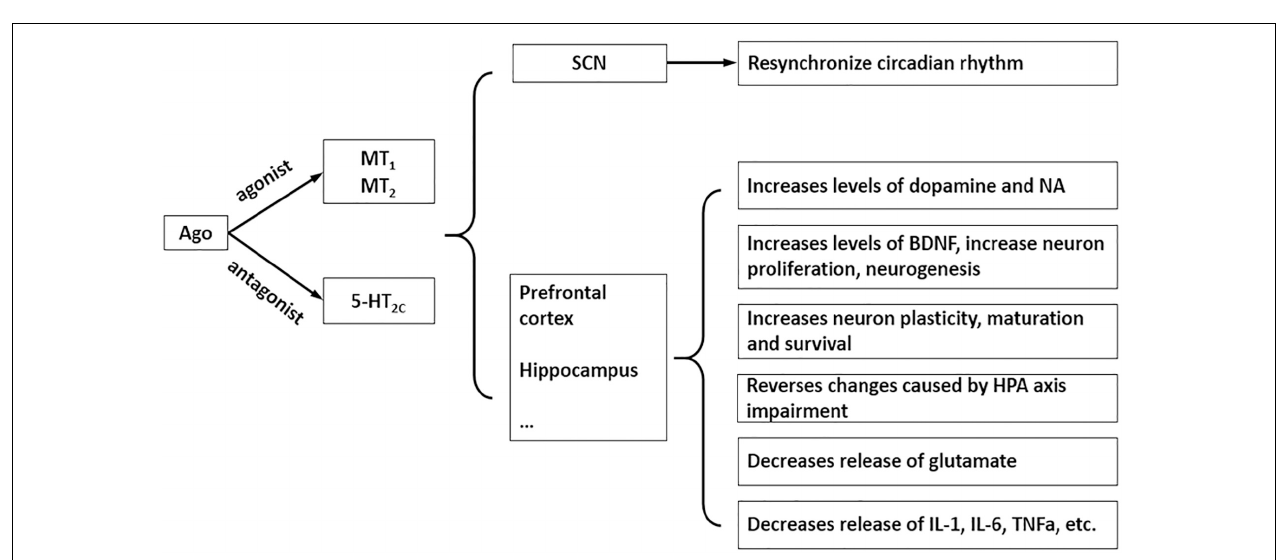
FIGURE 2 | Chief mechanisms and pharmacological properties of AGO. SCN: suprachiasmatic nucleus.